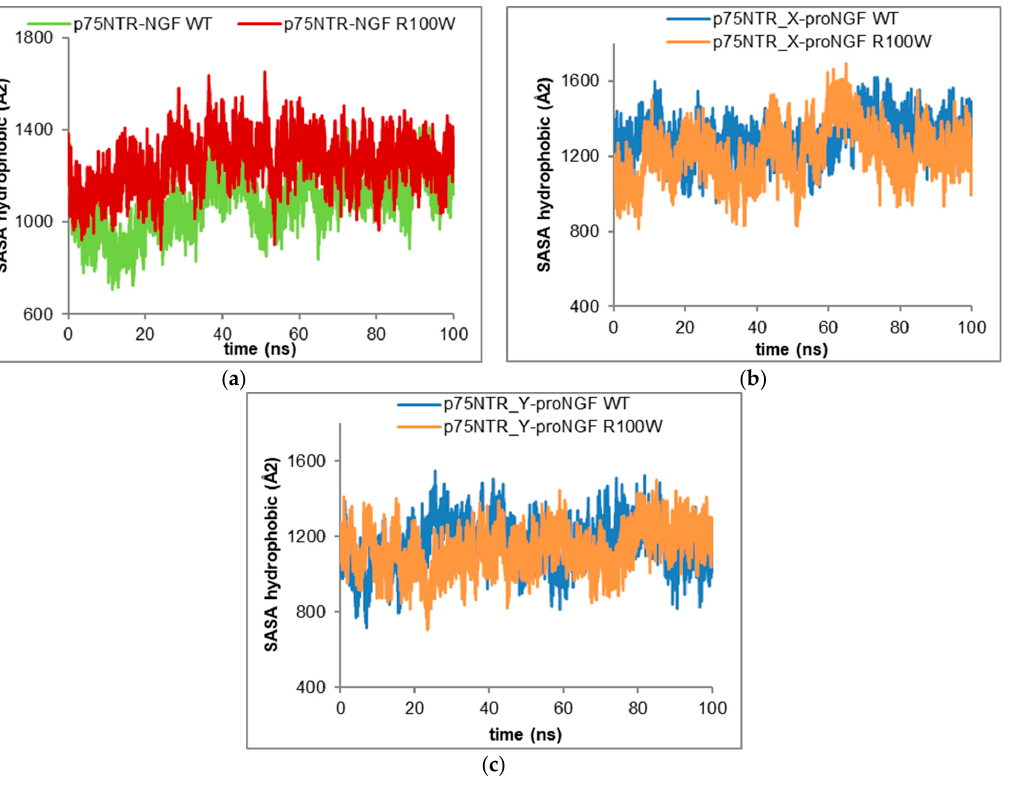
Figure 7. Time-evolution hydrophobic Solvent Accessible Surface Area trajectories of the complexes: ( a ) p75NTR/NGF, ( b ) p75NTR_X/proNGF, and ( c )